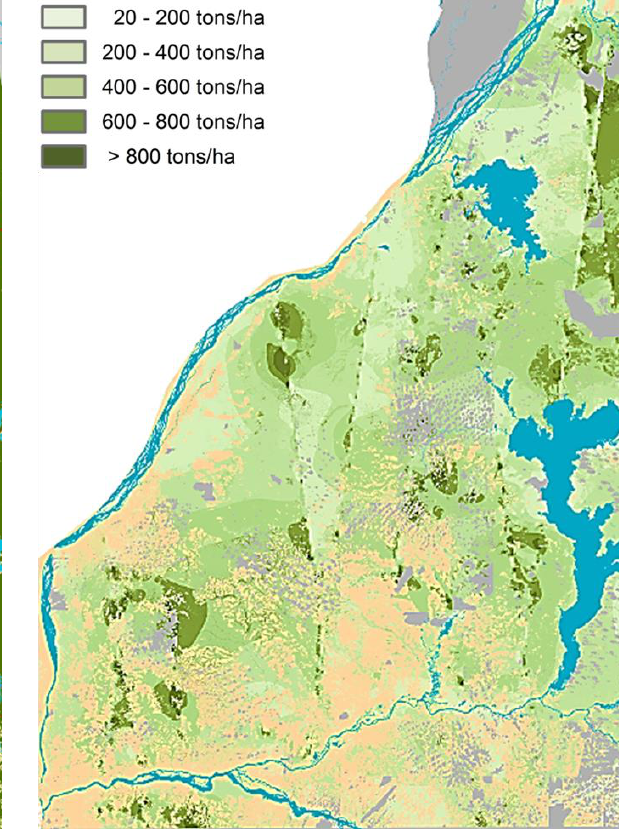
Figure 8. Above ground biomass based on 2003-2009 ICESat GLAS data. Beige is non-forest and grey are